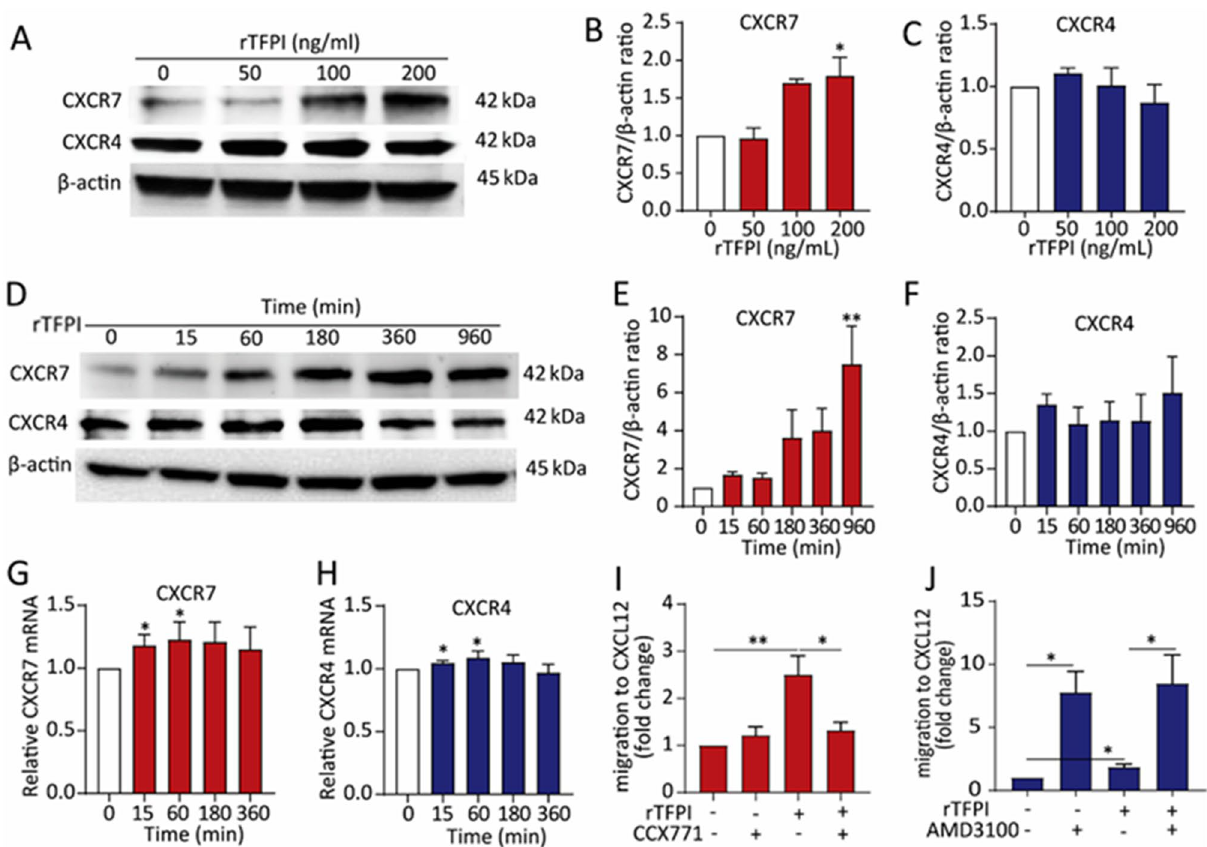
Figure 3. CXCR7 plays a key role in the effect of TFPI on the CXCL12-mediated TEM of CLL cells. ( A ) Western blotting and ( B , C ) quantification of CXCR7 and CXCR4 expression, relative to β-actin, after treating CLL cells with different doses of rTFPI for 24 h. n = 3 individuals, *P < 0.05. ( D ) Western blotting and ( E , F ) quantification of CXCR7 and CXCR4 expression, relative to β-actin, after treating the CLL cells with 200 ng/mL rTFPI for 0, 15, 60, 180, 360 and 960 min. n = 4 individuals, **P < 0.01. ( G , H ) mRNA expression of CXCR7 and CXCR4 was detected by quantitative PCR, relative to TBP, after treating the CLL cells with 200 ng/mL rTFPI for 0, 15, 60, 180, 360 and 960 min. n = 4 individuals; *P < 0.05. ( I ) After 24 h exposure of 200 ng/mL rTFPI, CLL cells were treated with 2 µM CCX771 for 1 h before they were used in the TEM assay. DMSO was